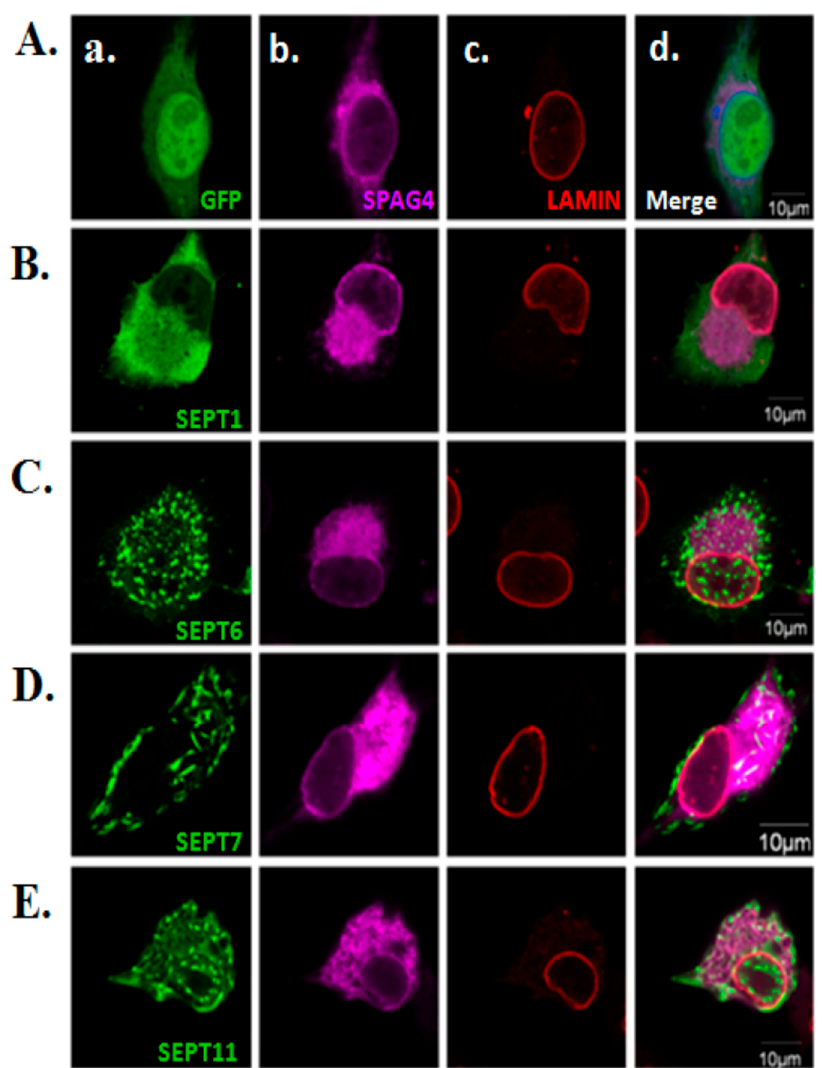
Figure 5. Effects of SEPT1/6/7/11 overexpression on the morphology of the NE in the NT2/D1 male germ cell line. Immunofluorescence staining with the anti-LAMIN antibody in the NT2D1 cells cotransfected with the pEGFP-empty ( A ), SEPT1 ( B ), SEPT6 ( C ), SEPT7 ( D ), or SEPT11 ( E ) vectors and pFLAG-SPAG4 vector. (a) Anti-EGFP antibody (green), (b) anti-FLAG antibody (pink), and (c) anti-LAMIN antibody (red); (d) image obtained after merging the images in (a), (b), and (c). Scale bar: 10 μ m.